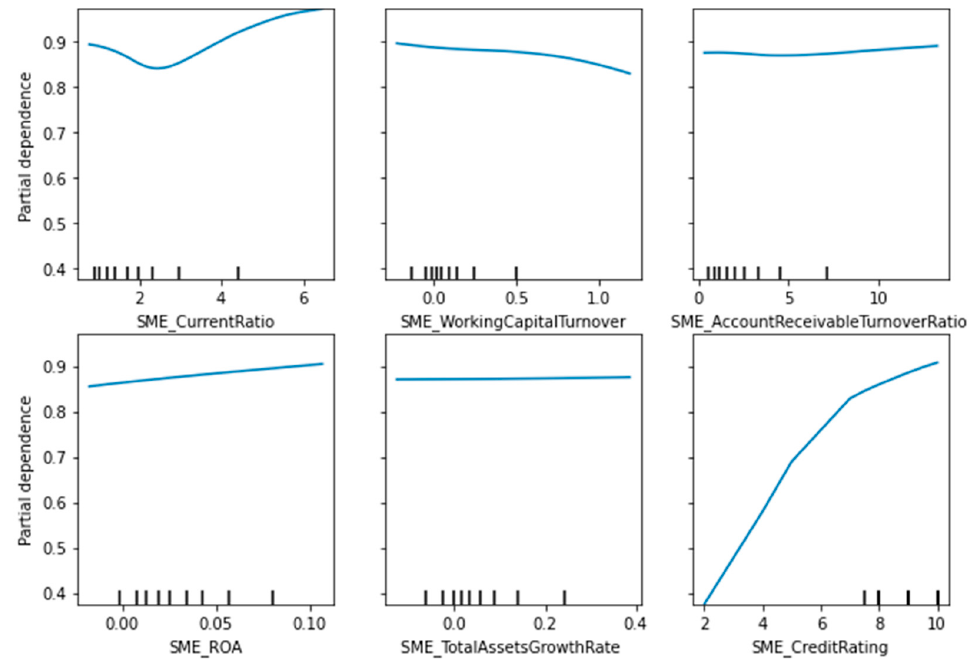
Figure 6. The PDP of SMEs’ traditional financing features based on the XGBoost-MLP. Figure 7 indicates the PDP of DSCF features of SMEs including the features of core enterprise, the digitalization feature of SMEs, and the trading features in the supply chain.